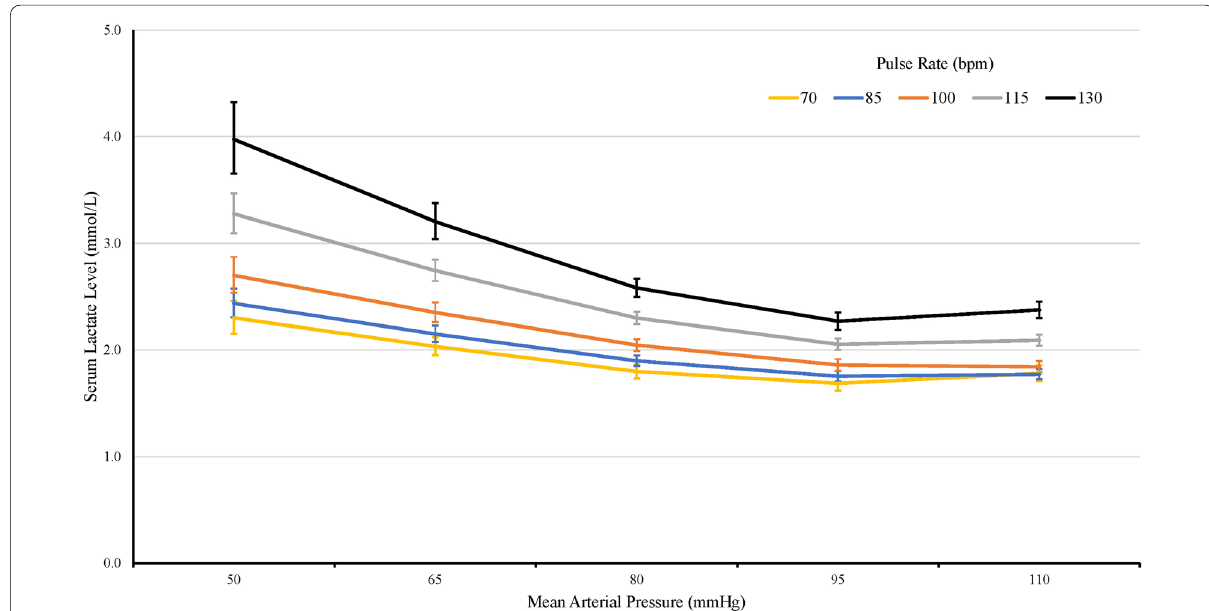
Fig. 2 Model-estimated serum lactate level by mean arterial pressure and heart rate. Error bars represent 95% confidence